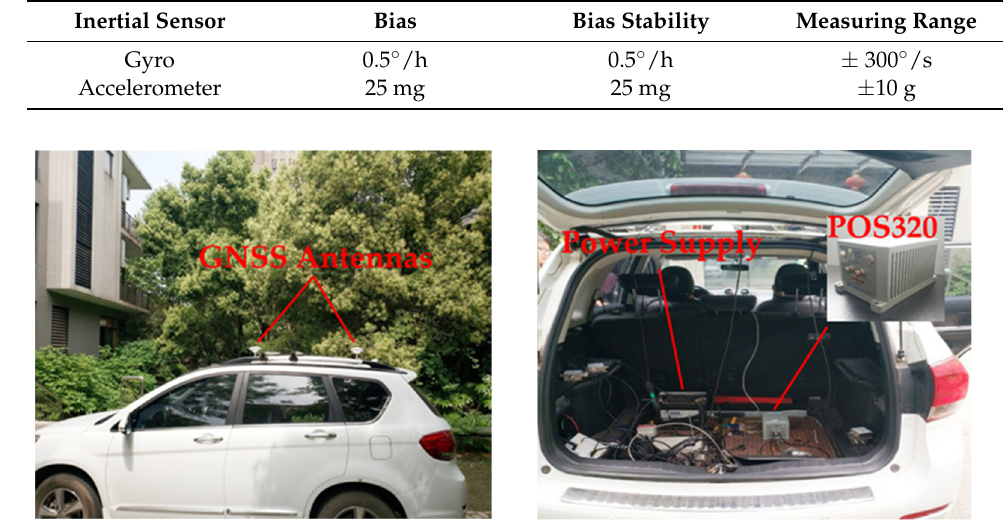
Figure 6. Test equipment.